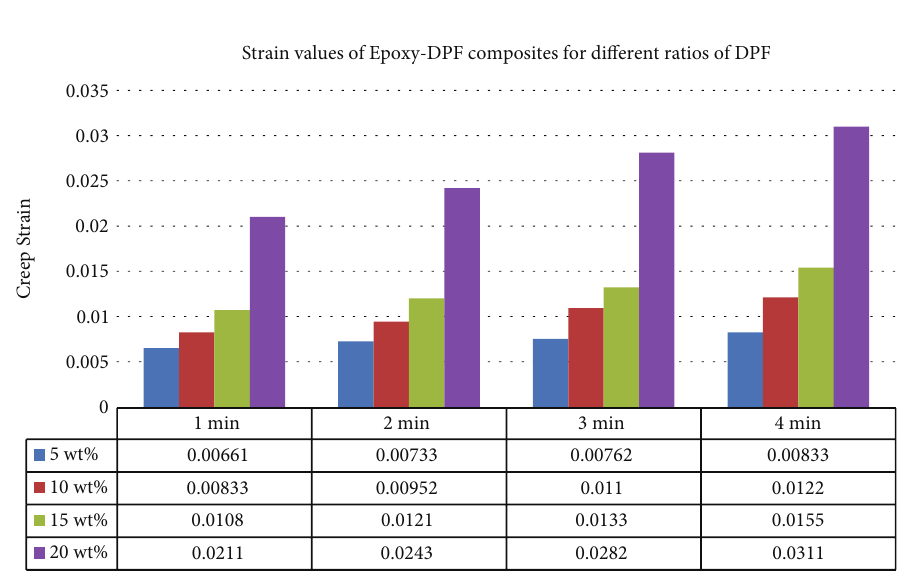
Figure 6: Impact strength results for di ff erent weight ratios (i.e., 5, 10, 15, and 20 wt%) of DPF in the tested notched specimens.